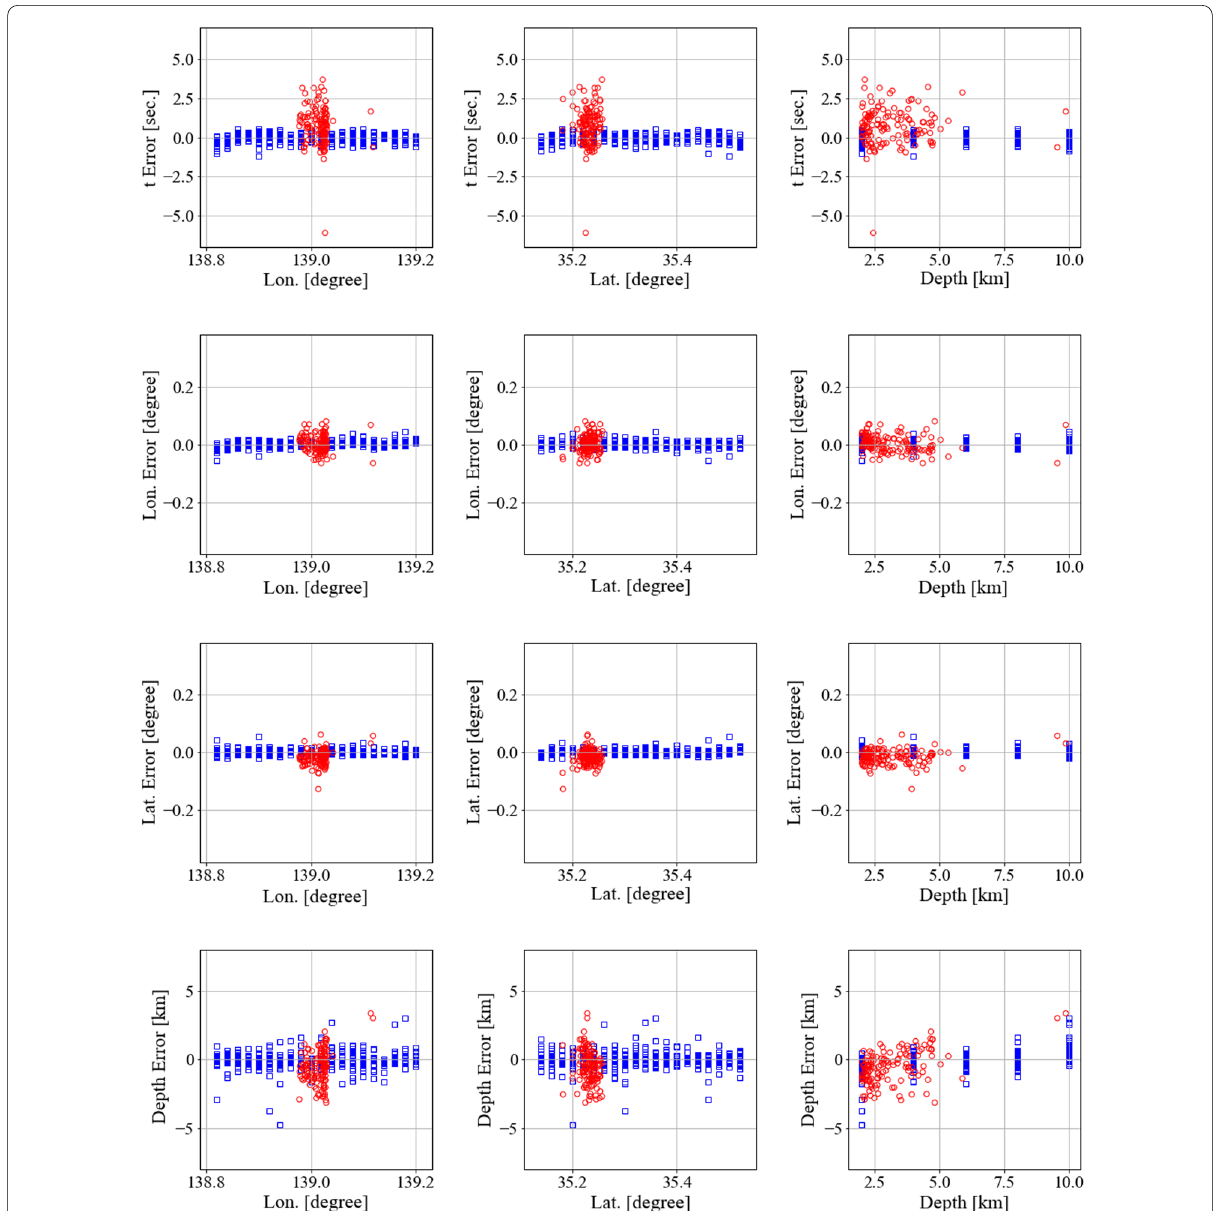
Fig. 8 Distribution of errors for hypocentral parameters determined by the proposed technique. Each column shows geographical distribution of errors for hypocentral parameters. Each row shows errors of origin time, longitude, latitude and depth, from top to bottom. Red symbols show observation and blue symbols show